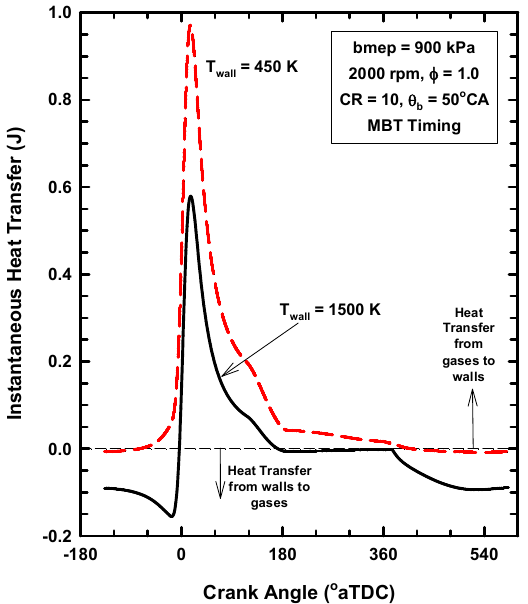
Figure 4. Instantaneous heat transfer as functions of crank angle for cylinder wall temperatures of 450 and 1500 K.